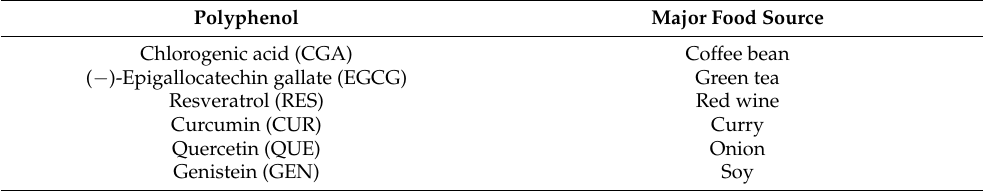
Table 1. Major food sources of